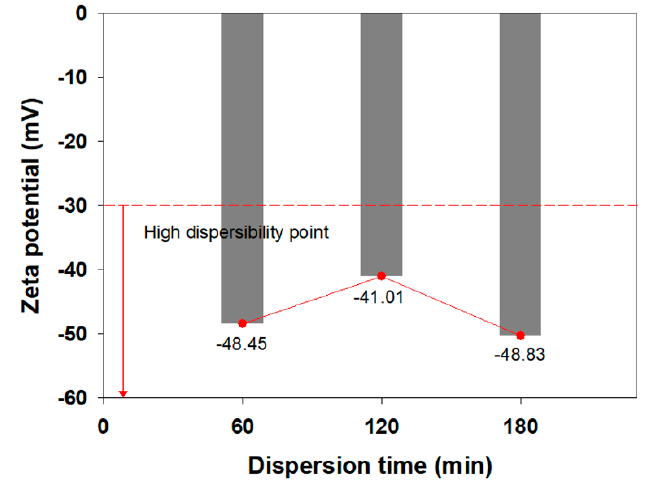
Figure 5. Zeta potential of CNC samples as a function of the magnetic dispersion time.